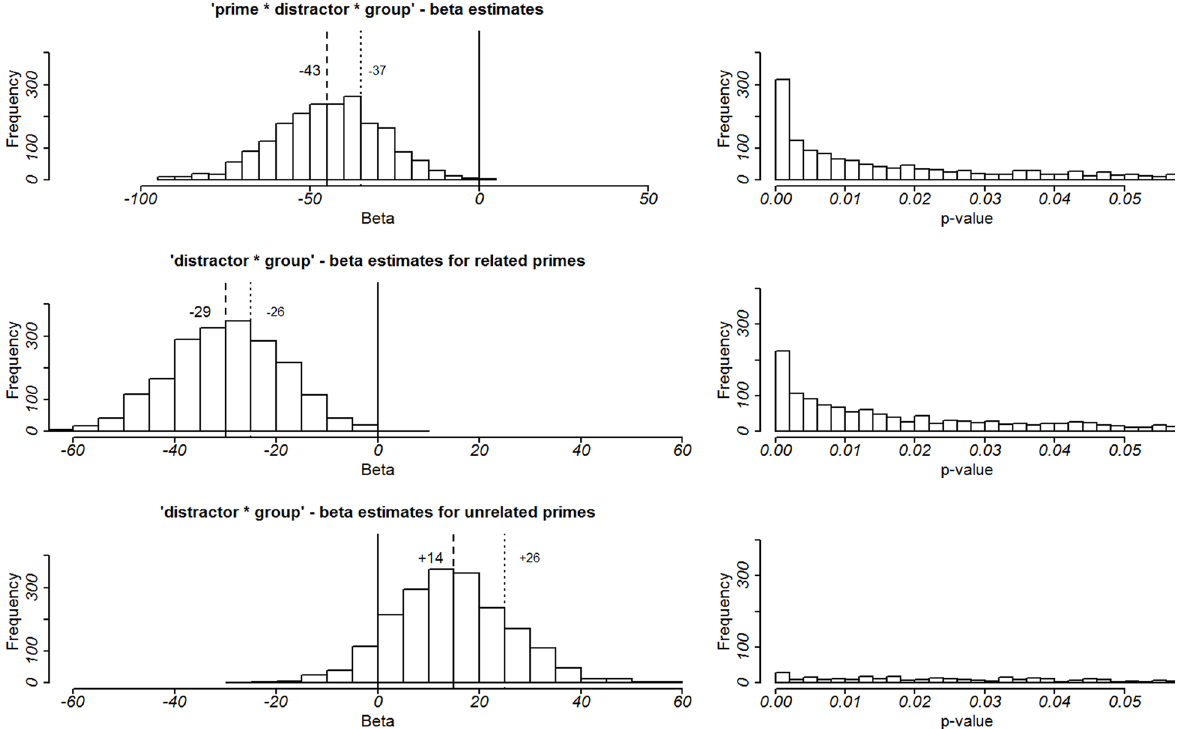
Fig 4. Results of the bootstrap approach: frequency distributions of beta estimates and p-values. Plots on the left show the frequency distribution of beta estimates for the bootstrap samples for the interaction between prime relatedness, distractor relatedness and group (top line), the interaction between distractor relatedness and group in the related (middle line) and unrelated (bottom line) prime condition. The dashed lines show the beta estimate of our original sample. The dotted lines show the minimal value the beta value has to reach to become statistically significant. Plots on the right show the frequency distribution of p-values below